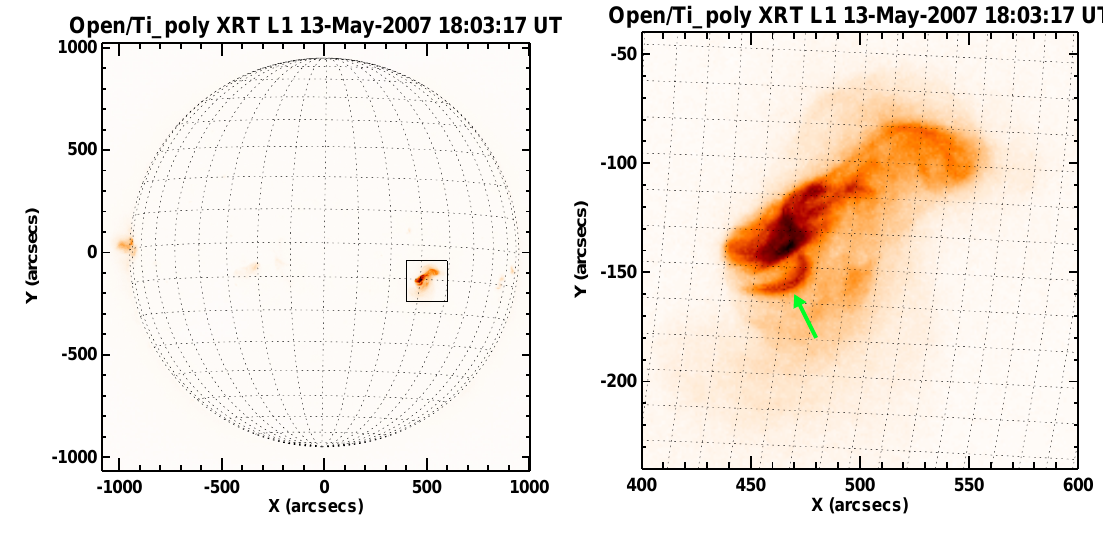
Fig. 5. On the left: full Sun image obtained by XRT/ Hinode with Ti poly filter. On the right: enlarged map of NOAA 955 active region observed by Hinode /XRT telescope with Ti poly filter. The DEM distribution, presented on Fig. 7, was calculated for the loop pointed by the green